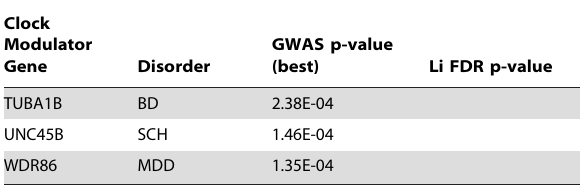
obtained from SLEP (middle), and 3) an FDR-corrected p-value for any gene that was determined to be nominally lithium-responsive (right). Bold